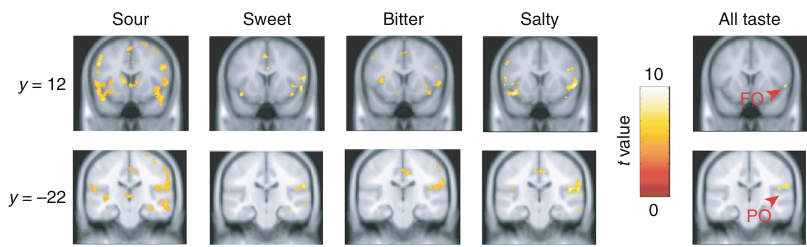
Fig. 3 Multivoxel patterns supporting taste types outside the insula. Whole brain searchlight analysis revealed the frontal and parietal operculum also discriminate four taste types ( n = 20 participants). FO: frontal operculum, PO: parietal operculum